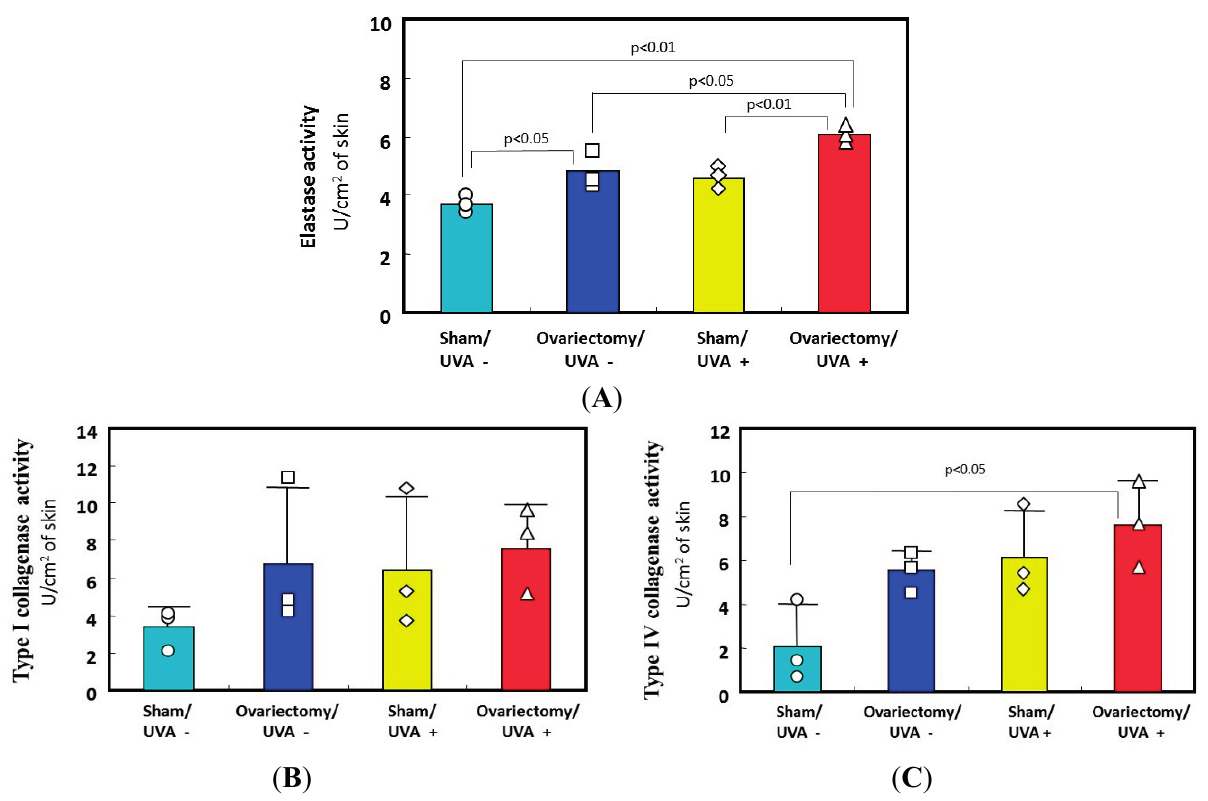
Figure 5. Effects of ovariectomy with or without UVA irradiation on the activities of elastase, collagenase I, and collagenase IV. ( A ) elastase activity; ( B ) type I collagenase activity; ( C ) type IV collagenase activity. Data represent means ± SD. ∆□○◊ : each measured